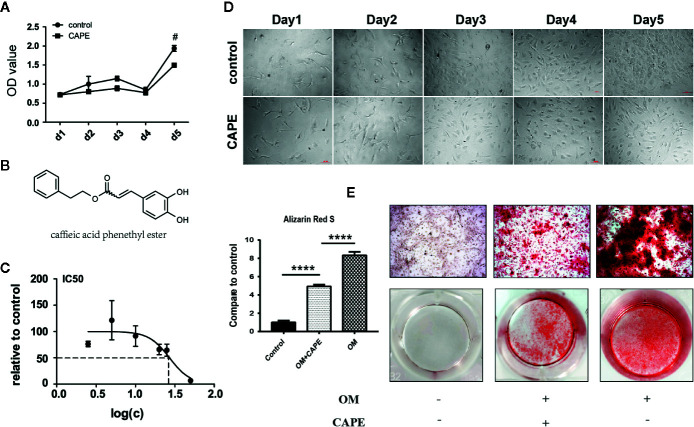
Viability and calcification of AVICs with treatment of CAPE. (A) Cell proliferation curve with or without CAPE treatment (10 μM) for 5 days, (B) Molecular structure of CAPE. (C) IC50 of CAPE on AVICs, concentrations were transferred to Log(c); n = 5. (D) Cell morphology of AVICs with or without CAPE treatment (10 μM) for 5 days. (E) Alizarin Red S staining of the cells with different conditioned coloring: control (normal culture medium), OM (osteogenic medium), OM+CAPE (osteoblastic medium plus CAPE treatment); #
p < 0.05 and ****p < 0.01 were accepted as significant difference, n=3.